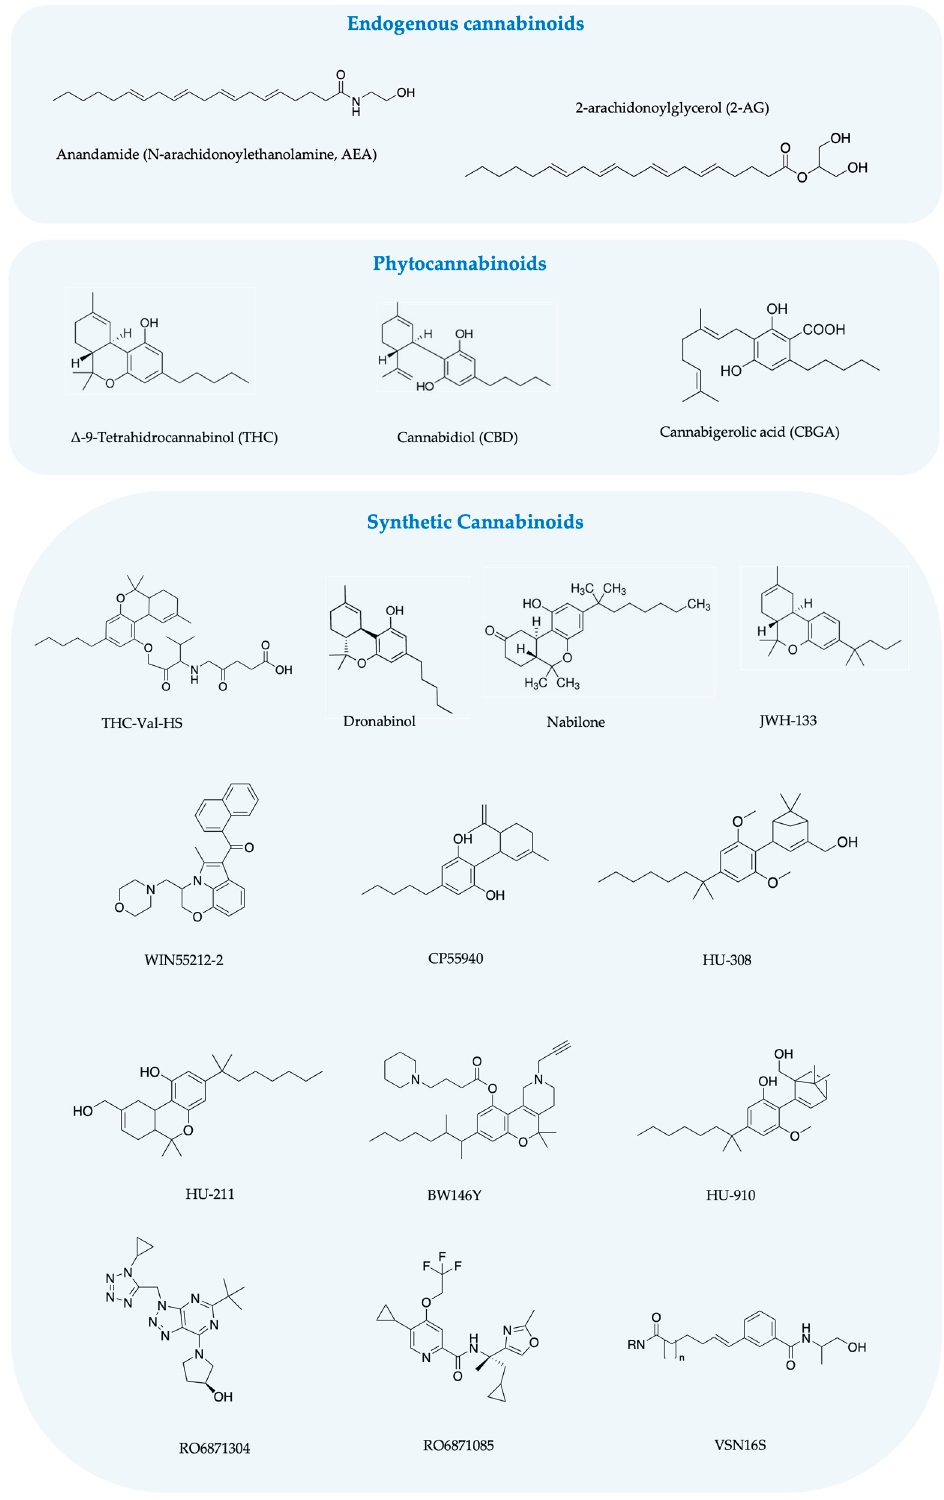
Figure 2. Chemical structures of endocannabinoids, phytocannabinoids and synthetic cannabinoids with reported pharmacological potential in ocular diseases. However, cannabinoids generally present unfavorable physicochemical and biological properties, such as poor stability, hydrophobicity and an oily resin nature, among others [17,18]. These hurdles overall limit their bioavailability and access to the therapeutic